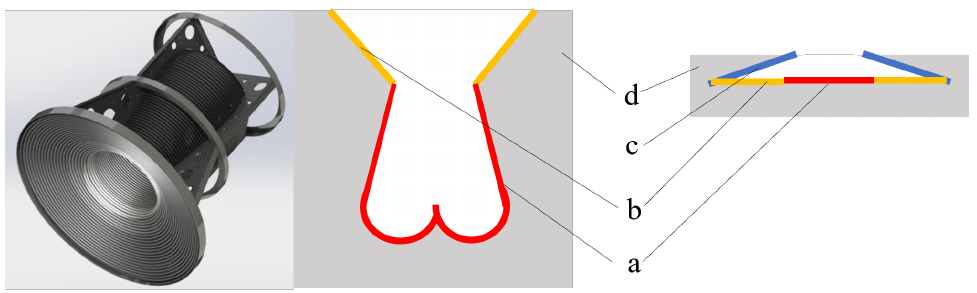
Figure 3. Comparison with ASTRI receiver design: ( a ) Area directly heated by concentrated solar rays; ( b ) area heated by conductive, convective and radiative energy; ( c ) highly reflective area, with no heat transferred to working fluid; ( d ) insulation. ( Left ): ASTRI 3-D and section view [9]; ( Right ): The positive conical cavity receiver.